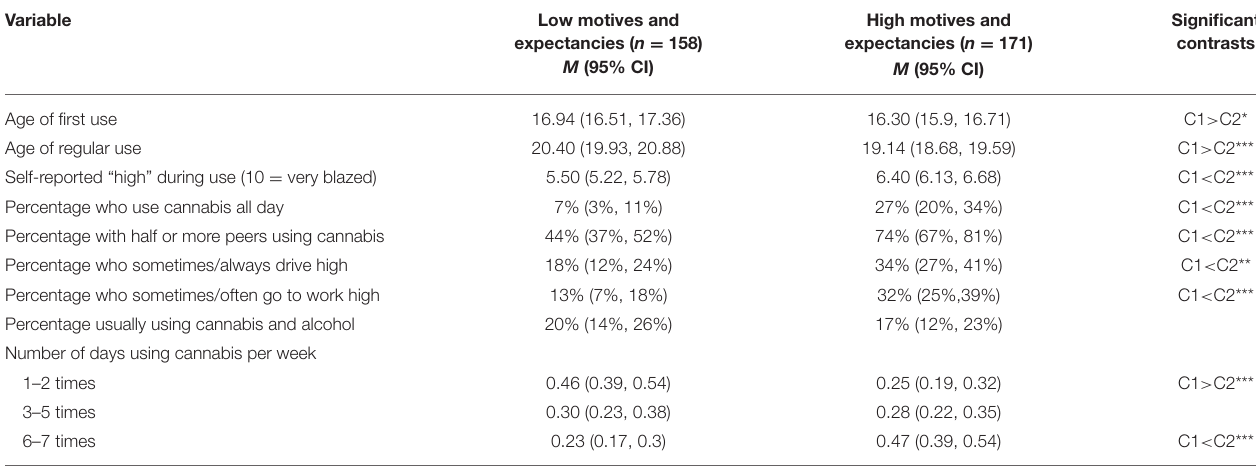
TABLE 4 | Means and confidence intervals of cannabis use variables (2-class model) a .